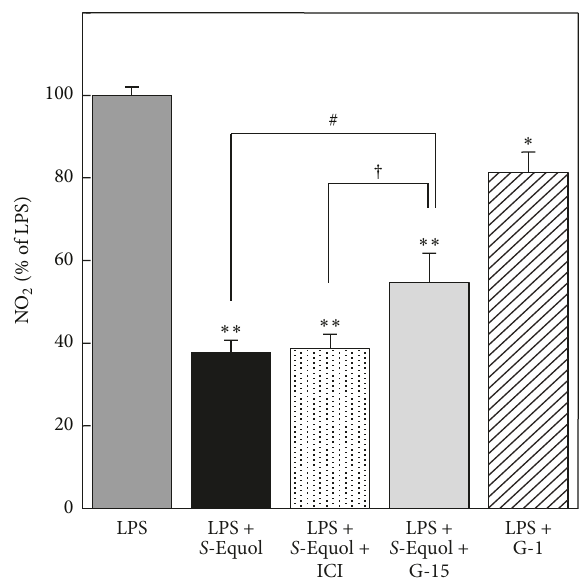
Figure 6: Effect of ER antagonist/agonist on LPS-induced NO production. Cultured astrocytes were treated with LPS (1 𝜇 g/ml) and S -equol (50 𝜇 M) in the presence of ICI 182.780 (an intracellular ER antagonist; 1 𝜇 M) or G-15 (a GPR30 antagonist; 1 𝜇 M) for 24 h, and NO production was evaluated as described in Figure 3. Some cultures were treated with LPS (1 𝜇 g/ml) and G-1 (a GPR30 agonist; 100nM) for 24 h, and NO production was determined. Data are the mean ± SEM of 5 samples. ∗ 𝑝 < 0.05 ; ∗∗ 𝑝 < 0.01 significantly different from LPS. # 𝑝 < 0.05 statistical difference between LPS + S -equol and LPS + S -equol + G-15. † 𝑝 < 0.05 statistical difference between LPS + S -equol + ICI and LPS + S -equol +